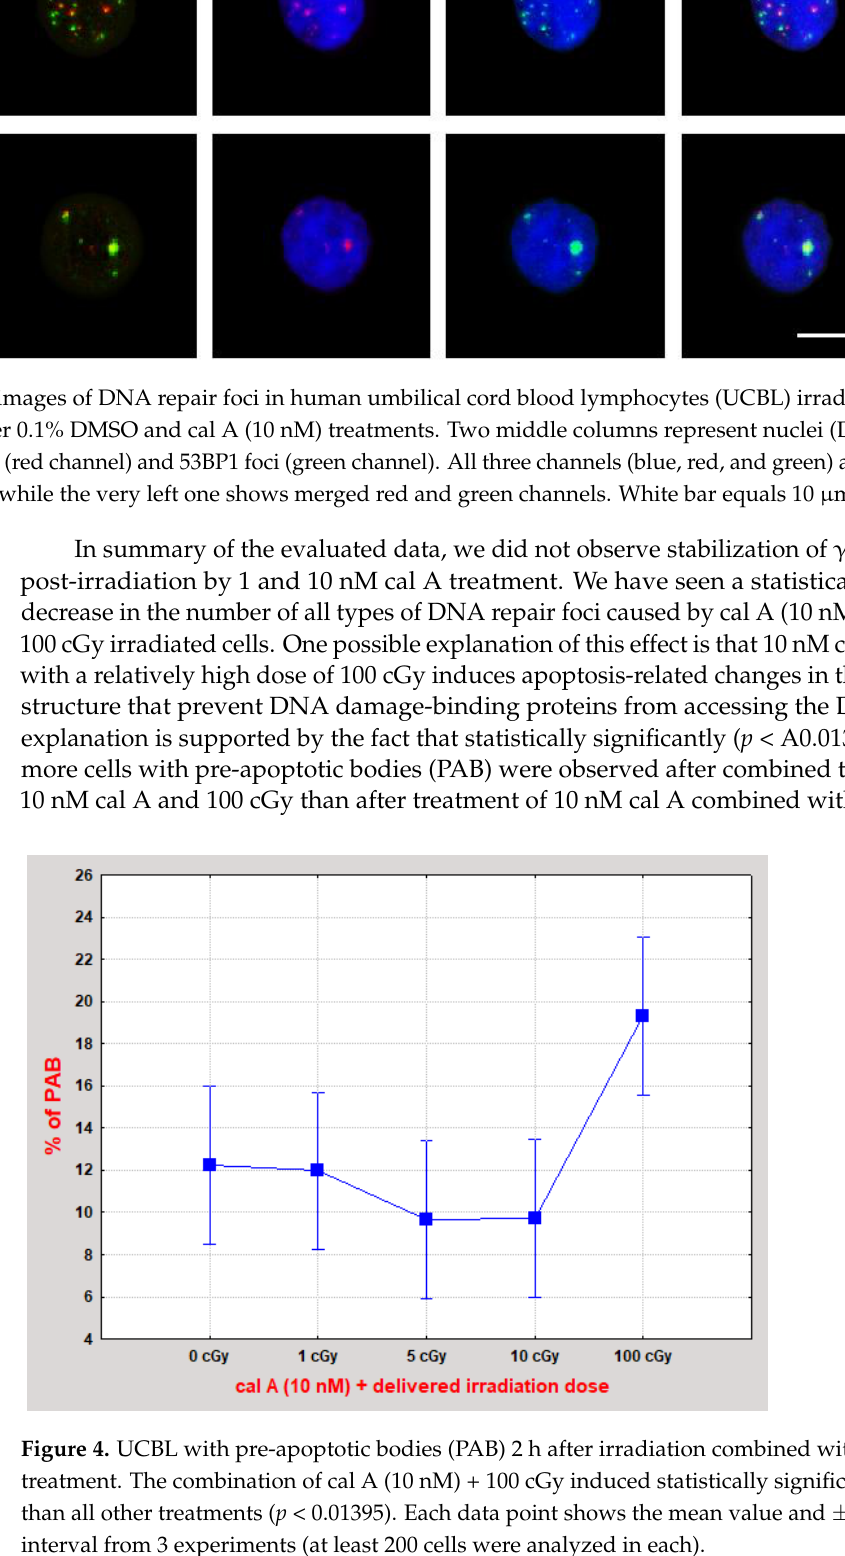
Figure 4. UCBL with pre-apoptotic bodies (PAB) 2 h after irradiation combined with cal A (10 nM) treatment. The combination of cal A (10 nM) + 100 cGy induced statistically significantly more PAB than all other treatments ( p < 0.01395). Each data point shows the mean value and ± 0.95 confidence interval from 3 experiments (at least 200 cells were analyzed in